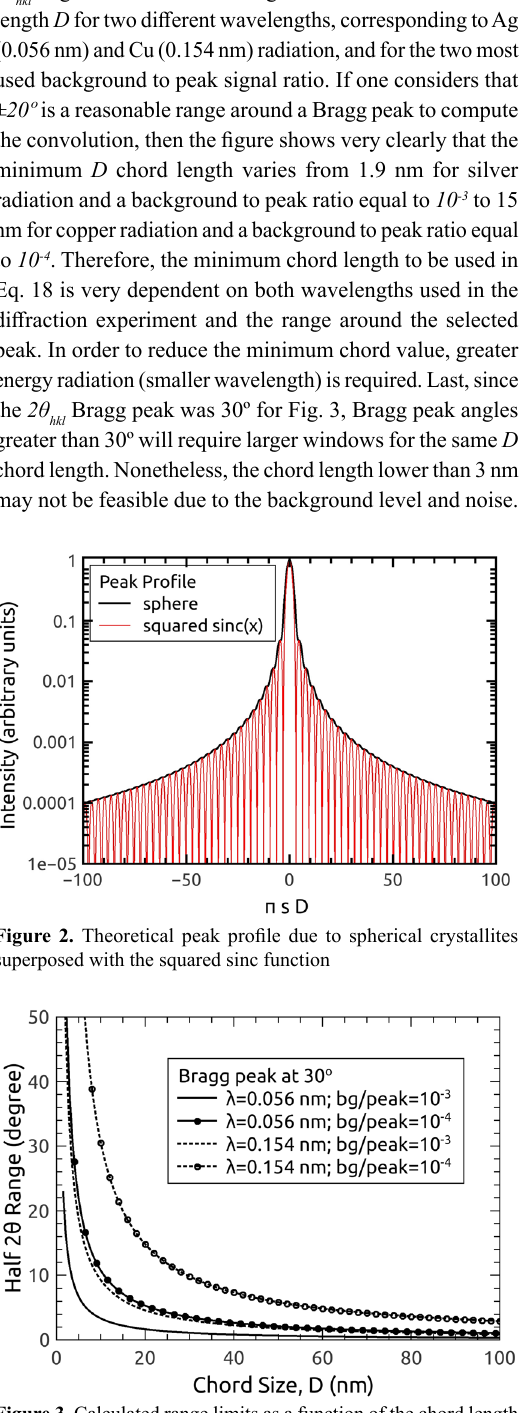
Figure 3. Calculated range limits as a function of the chord length D, the wavelength and the background to peak signal ratio As pointed out by Le Bail and Louër 18 , Fourier analysis of diffraction peaks may lead to crystallite size distributions perturbed by oscillations. They proposed a least squares smoothing procedure to eliminate the problem. Nonetheless, the